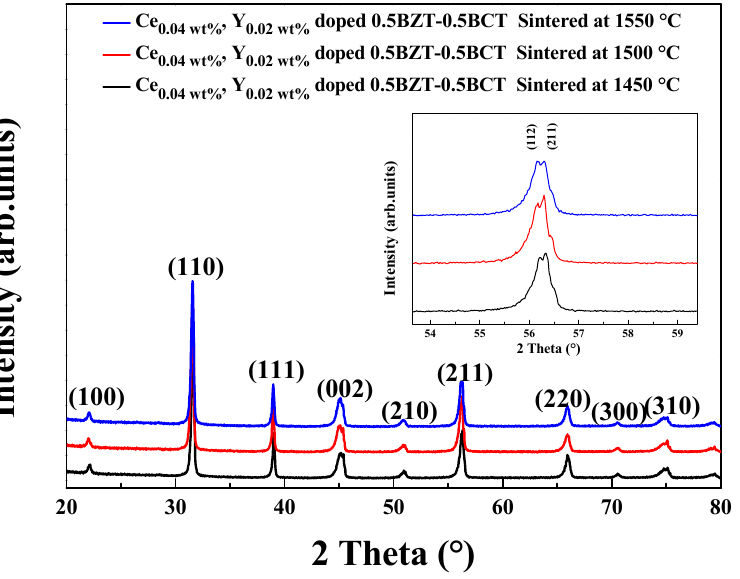
Figure 1. Sintering temperature-dependent X-ray diffraction patterns of Ba 0.85 Ca 0.15 )(Zr 0.1 Ti 0.9 )O 3 - Ce 0.04 Y 0.02 ceramics. The insert is a peak shift of (211) for different sintering temperatures from 1450 to 1550 °C.